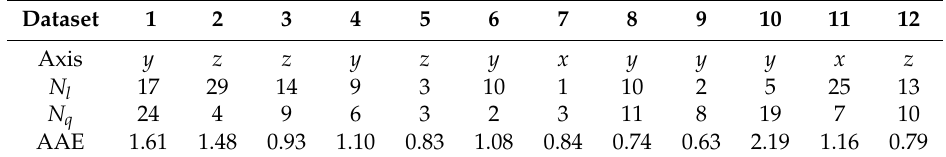
Table 4. AAE values obtained by performing motion artifact removal using the second-order Volterra